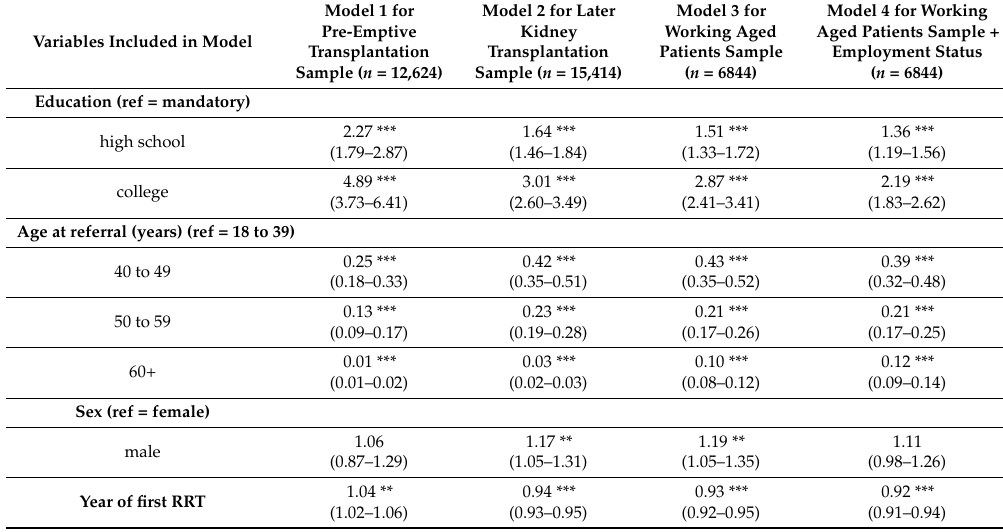
Table 5. Sensitive analyses for education by the multivariate logistic